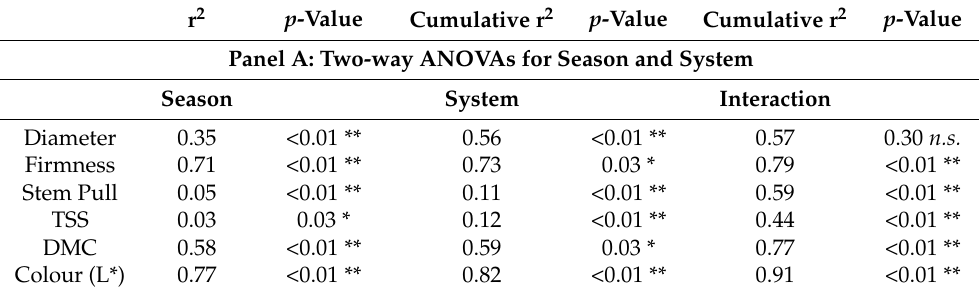
Table 6. Two-way ANOVA results for either training system (Panel A) or light interception (Panel B), and their interaction with season, on fruit quality characteristics of sweet cherry cultivar ‘Kordia’. The cumulative r 2 (proportion of variation explained) accumulates from the season effect alone. The p -values are from standard ANOVA F-tests. The cumulative r 2 of the interaction column is the equivalent to the overall model’s r 2 . Refer to the Appendix A for the full ANOVA tables (Tables A6–A17).